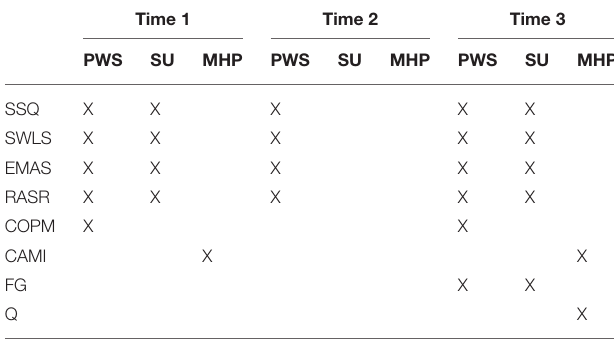
TABLE 2 | Outline of the mechanisms used for